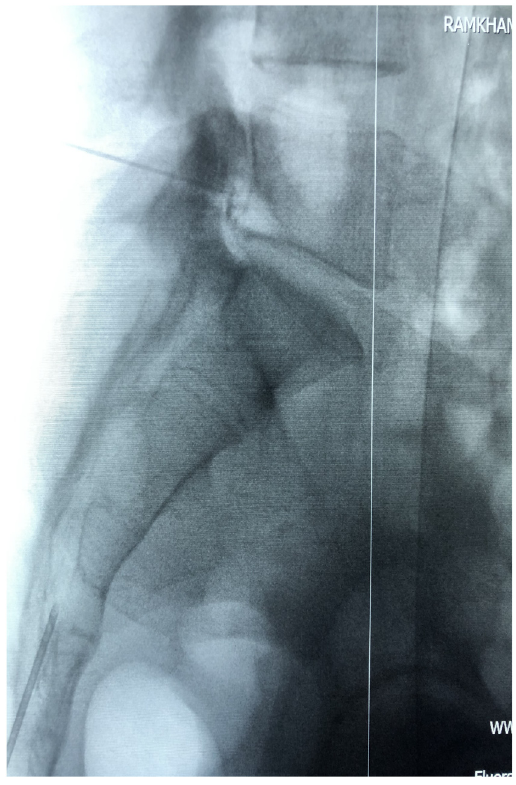
injection.Figure 1. An anteroposterior view of contrast flow in combined supraneural transforaminal and caudal with catheter